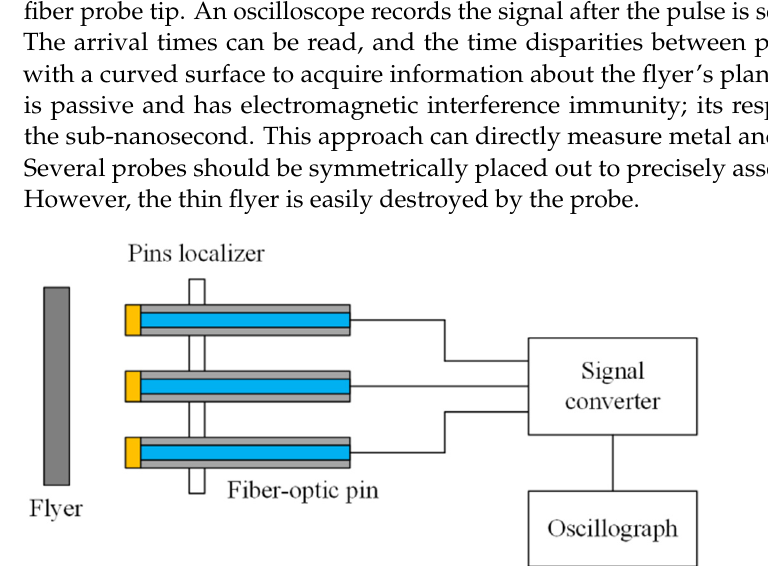
Figure 24. Optical fiber probe configuration.